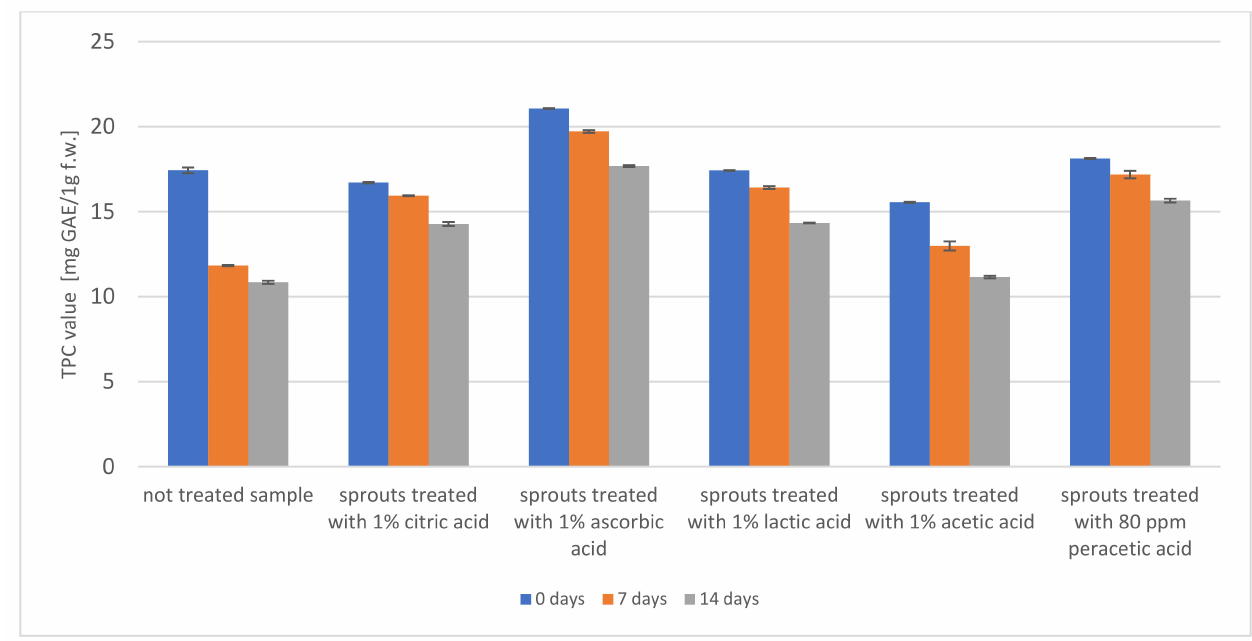
Figure 2. Total polyphenol content (TPC) in red cabbage sprouts with the addition of solutions of various organic acids subjected to 7- and 14-day storage. The graph shows the mean values and standard deviation ( n =